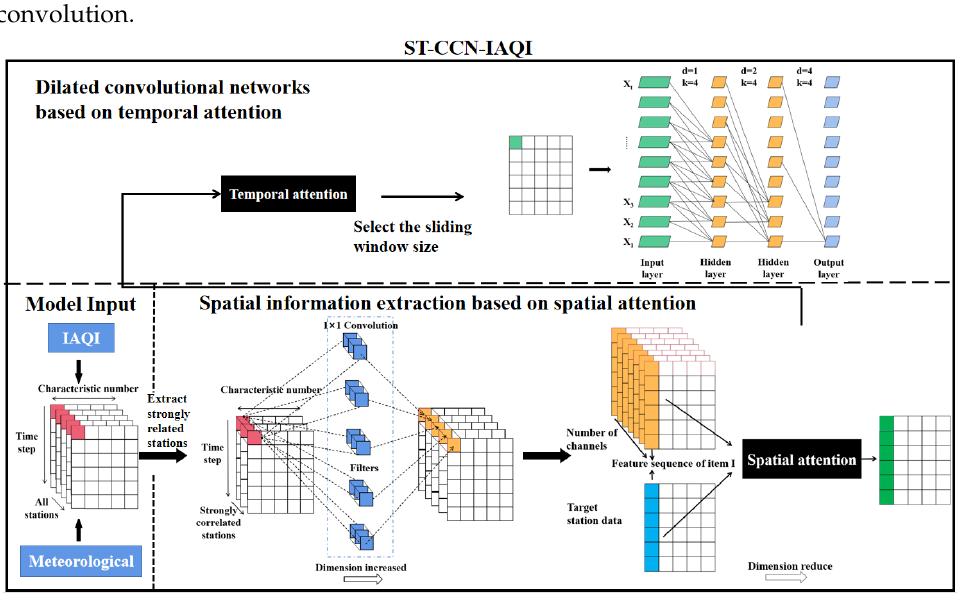
Figure 1. ST-CCN-IAQI architecture.